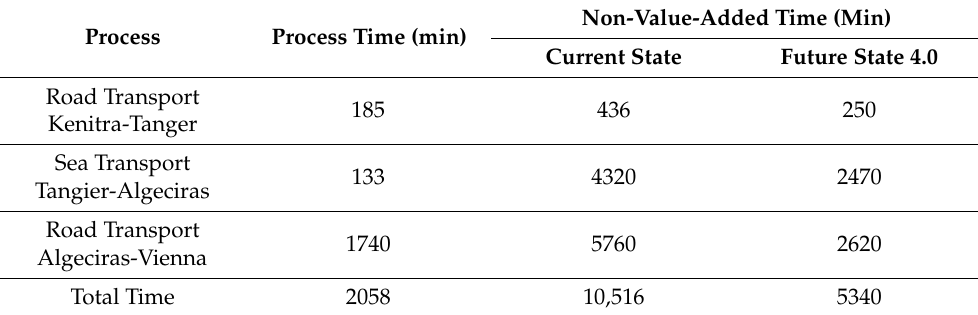
Indicator Current State